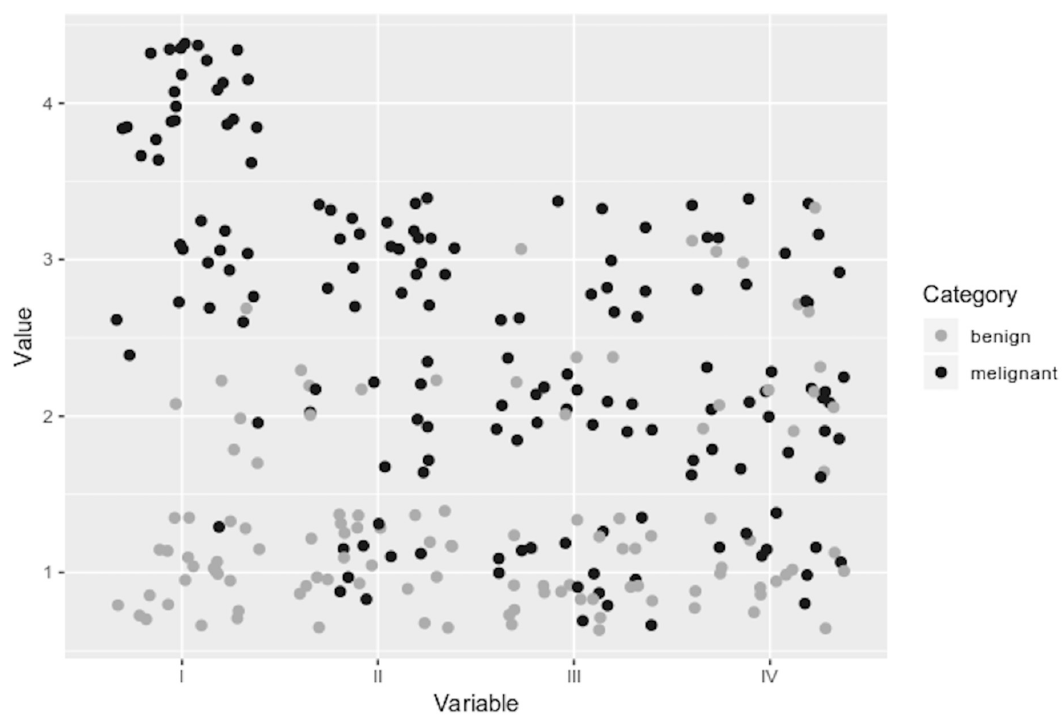
Figure 12. Distribution of the values of analysed variables. For better clarity, a jittered points plot was used.